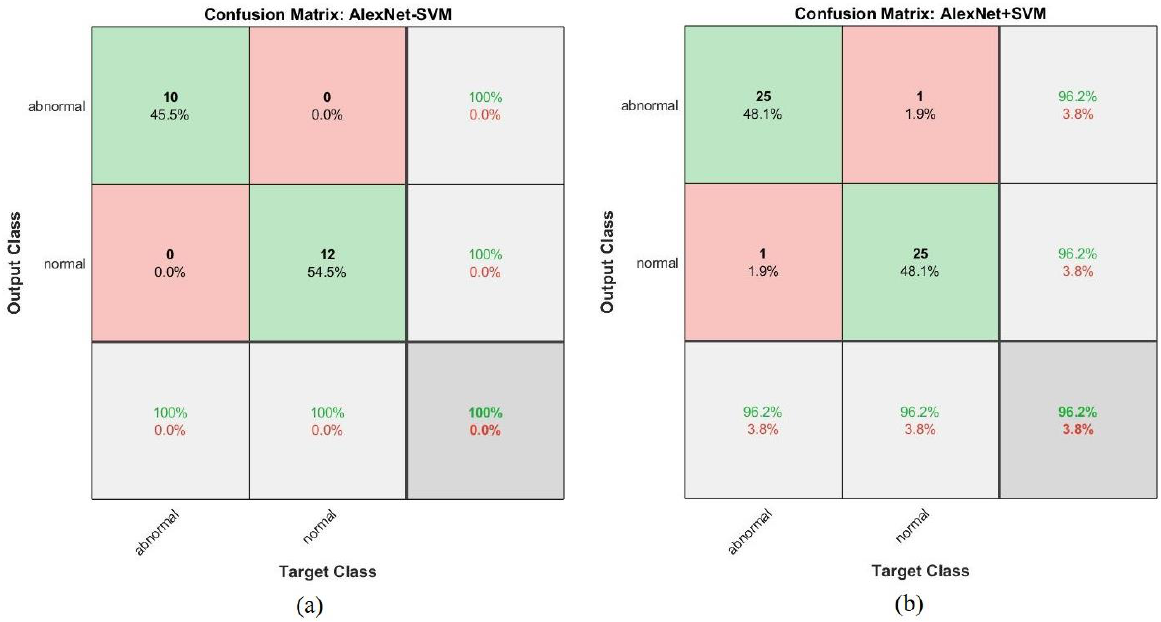
Figure 26. Confusion matrix for the AlexNet + SVM hybrid technique for the ( a ) ALL_IDB1 and ( b ) ALL_IDB2 datasets.